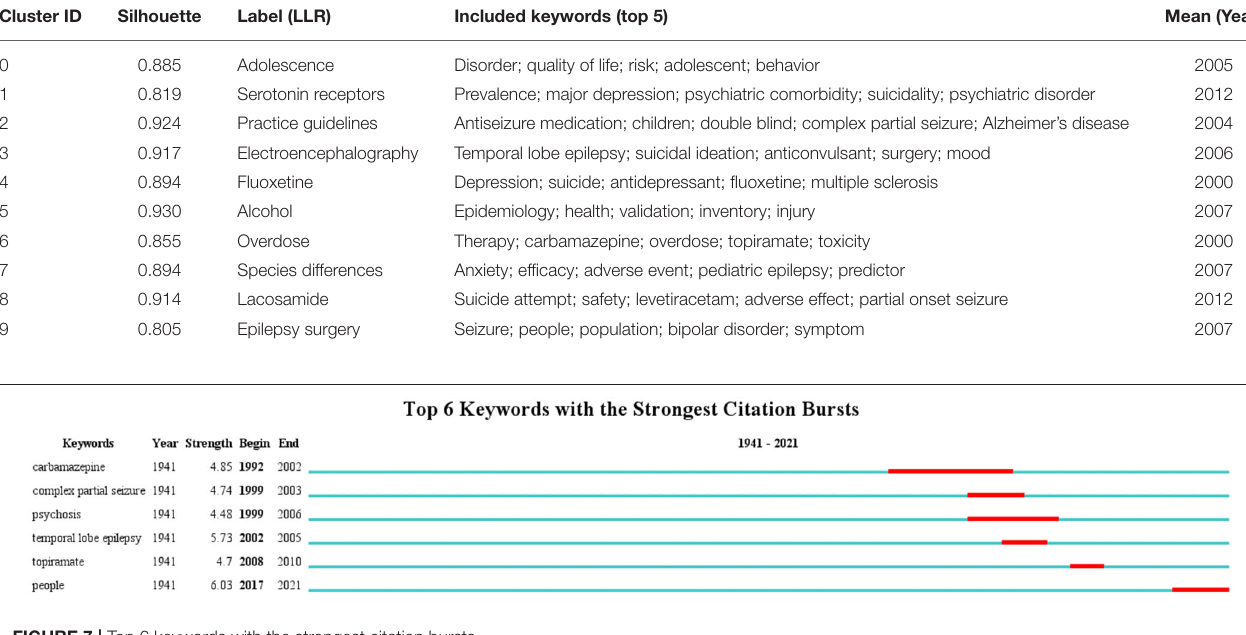
FIGURE 7 | Top 6 keywords with the strongest citation